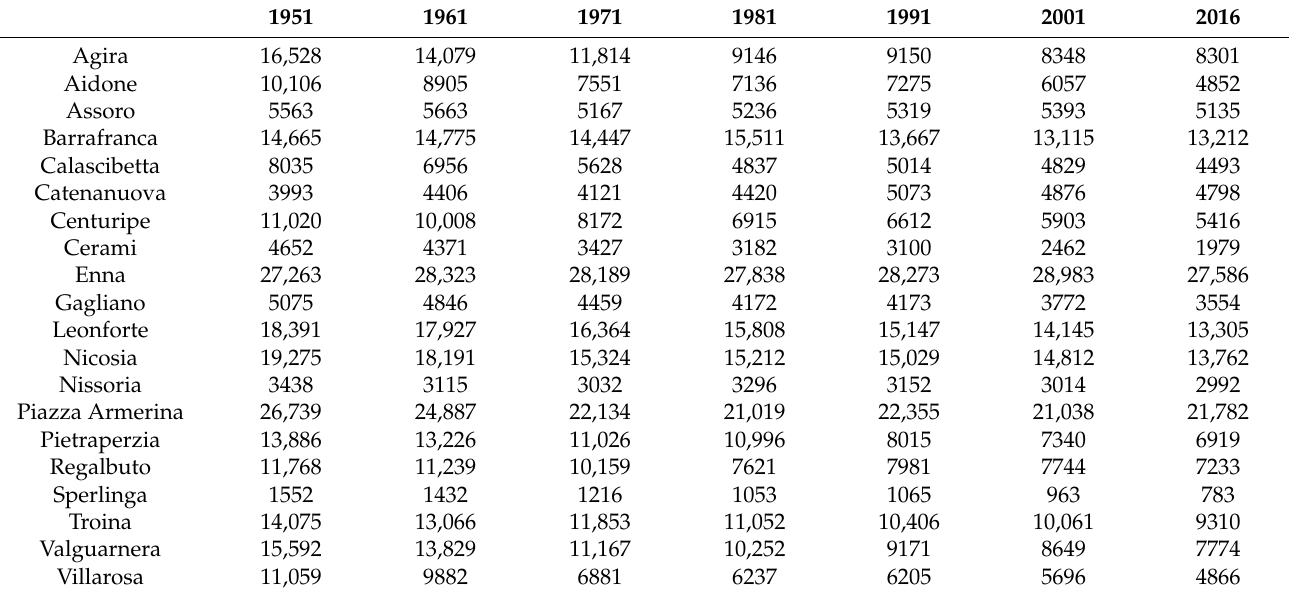
Table 1. Population dynamics in the 20 Municipalities of the Enna District.